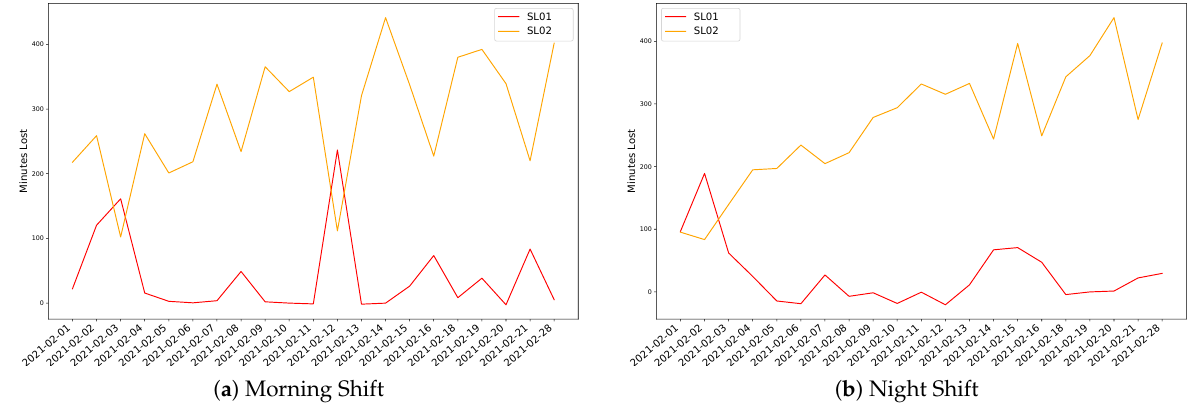
Figure 8. Production Losses at SCAN inspection units per production line and